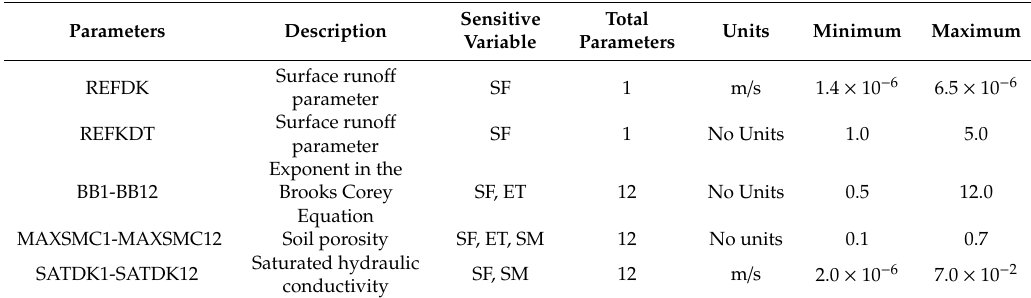
Table 2. Details of Noah-MP parameters used for